Question: What kind of plot is shown here?
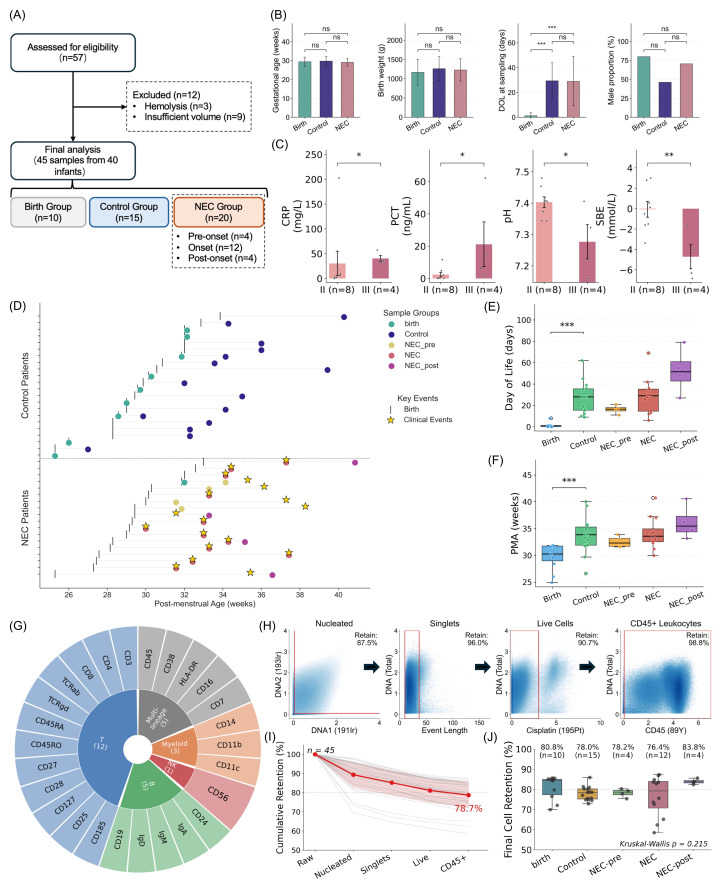
Answer: bar